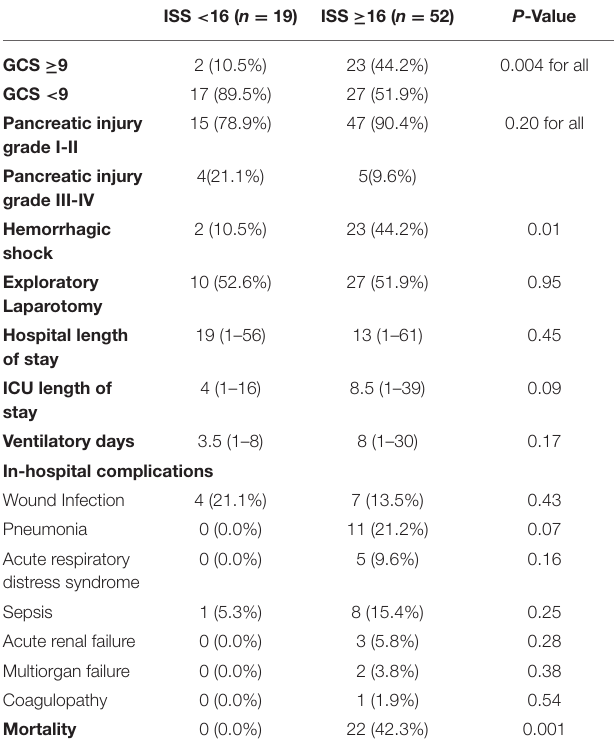
TABLE 5 | Pancreatic injury by severity of